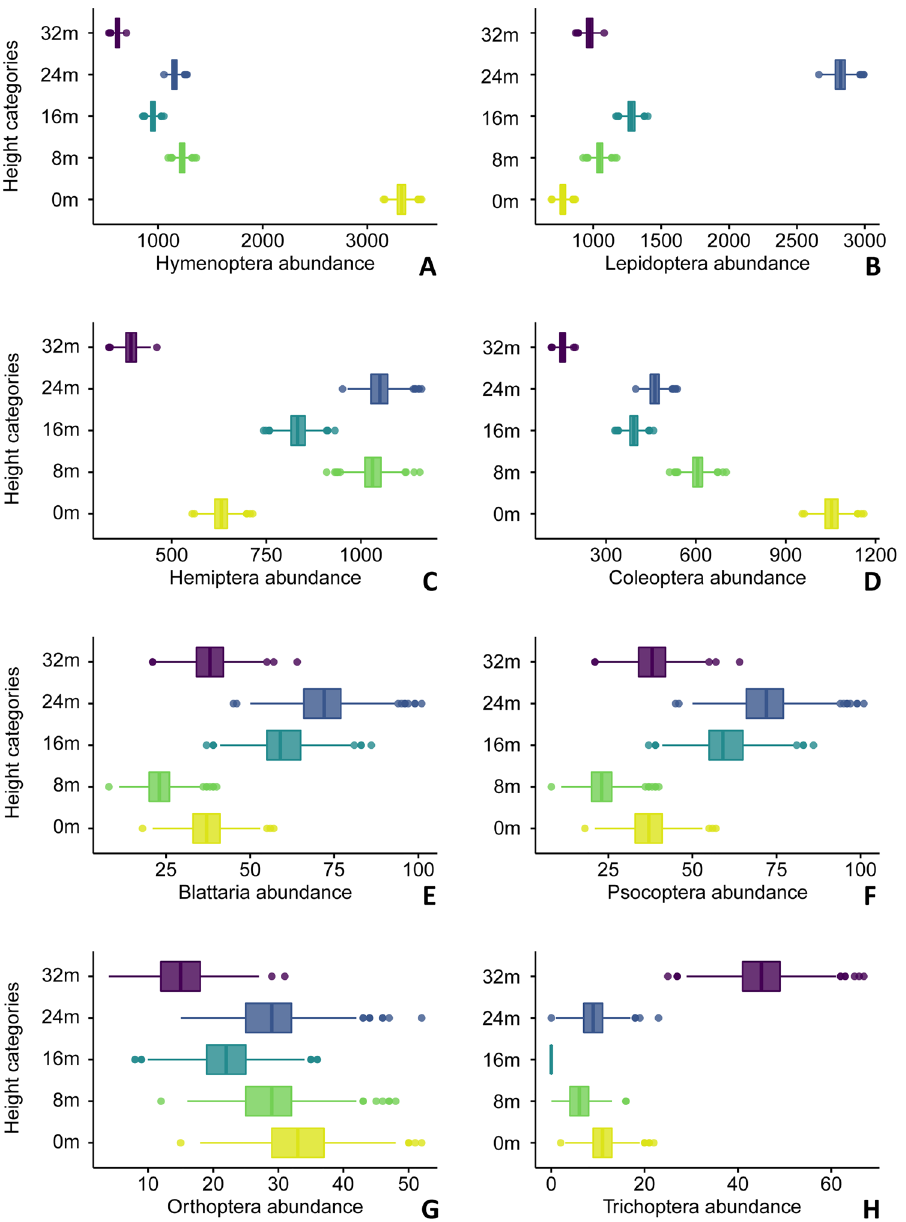
Figure 1. ( A – H ) Bar charts of simulated abundance based on the total counts of sampled hexapod orders across the canopy gradient (Diptera in Fig. 2). ( A ) Hymenoptera. ( B ) Lepidoptera. ( C ) Hemiptera. ( D ) Coleoptera. ( E ) Blattaria. ( F ) Psocoptera. ( G ) Orthoptera. ( H )